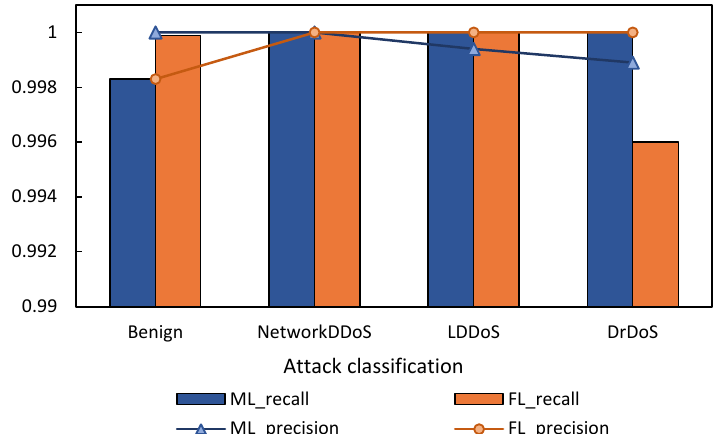
Figure 14. Comparison of FL and ML with uploading datasets.